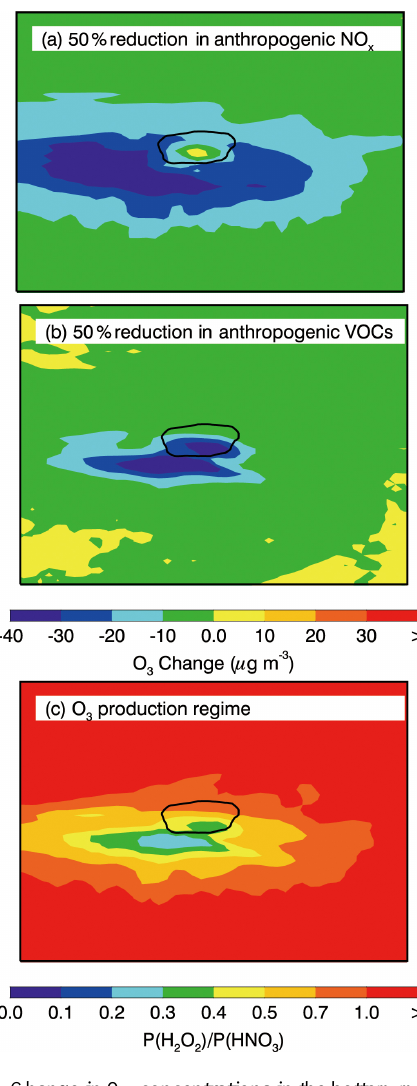
Figure 17. Change in O 3 concentrations in the bottom model layer, averaged during O 3 peak time from 22 to 24 August 2013 due to a 50% reduction in anthropogenic (a) NO x and (b) VOC emis- sions and the 3-day average ratio of P (H 2 O 2 )/P (HNO 3 ) during O 3 peak